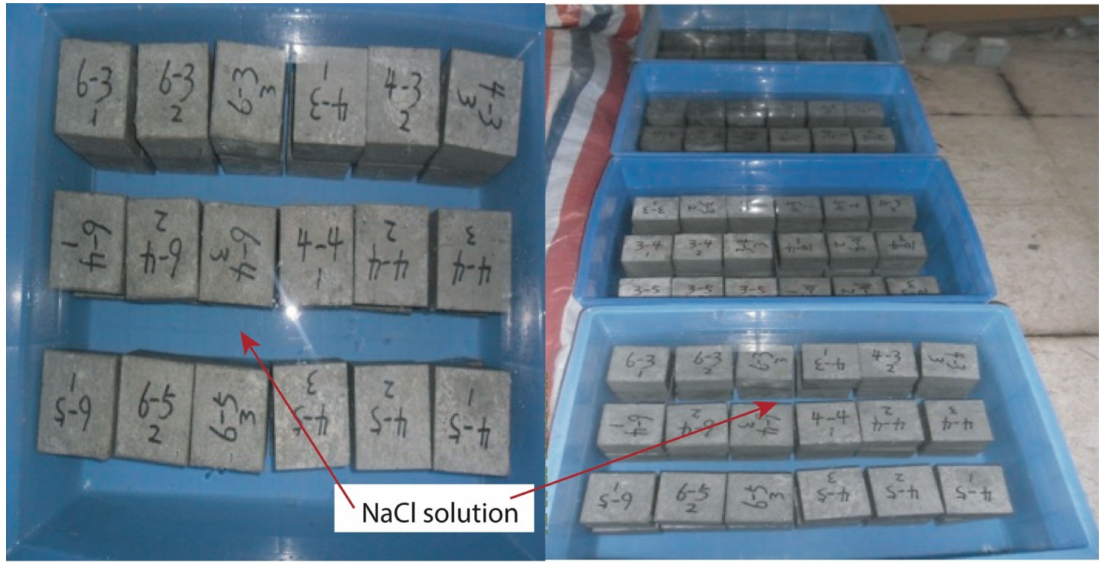
Figure 2. Soaking process of concrete